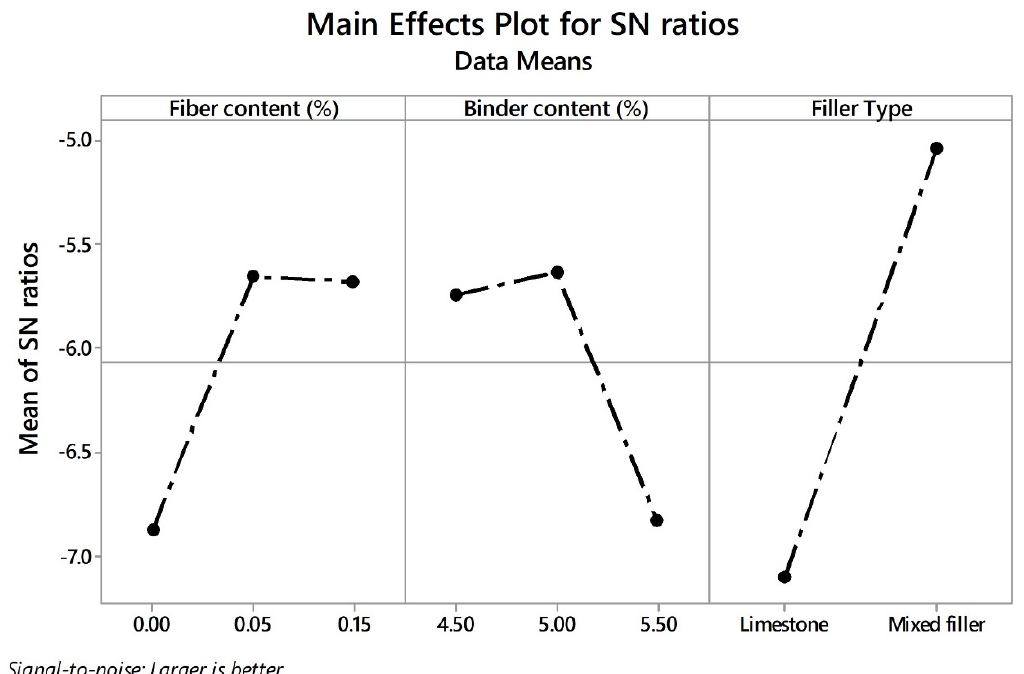
Figure 15. E ff ects of parameters on mean SN ratios for JPS value. Figure 15. Effects of parameters on mean SN ratios for JPS value. Figure 15. Effects of parameters on mean SN ratios for JPS value.